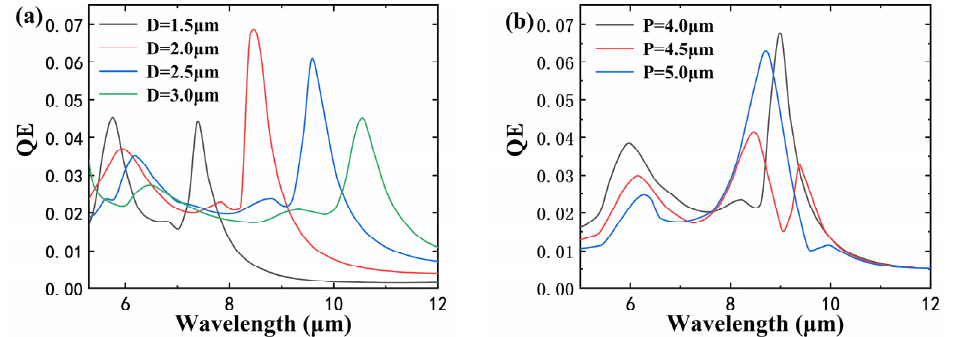
Figure 2. QE as a function of incident wavelength ( a ) at different micropillar diameters and ( b ) at different unit periods.